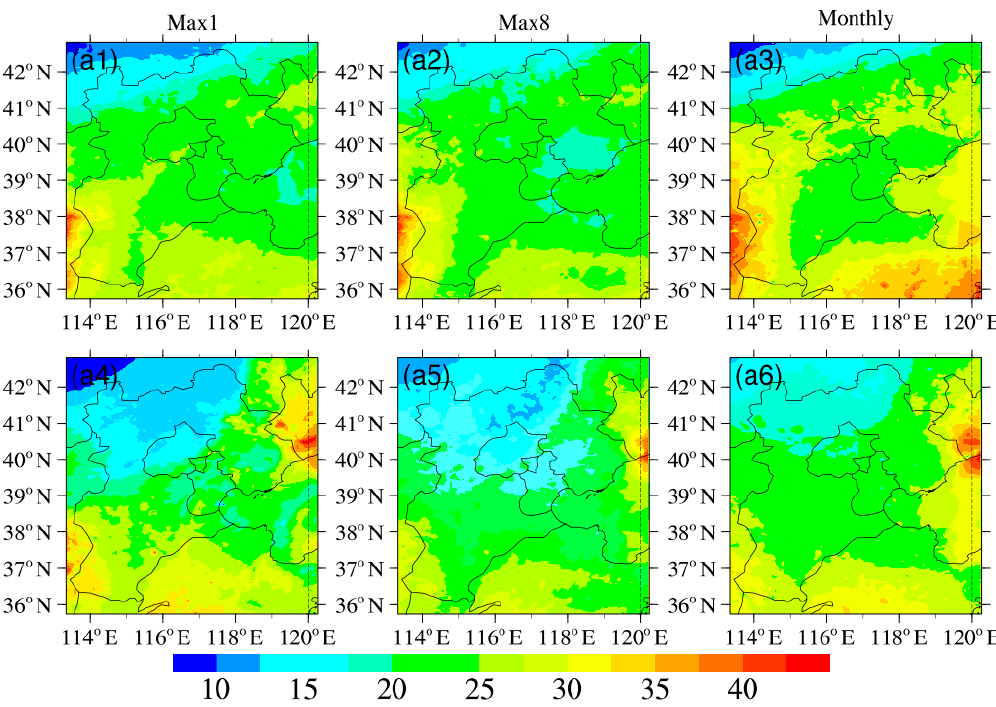
Figure 13. Monthly averaged contribution (µg/m 3 ) of BVOCs to ozone formation in July and August 2017 over the NCP ( a1 – a6 ); the left column represents the maximum 1-h average, the middle column represents the maximum 8-h average, the right column represents the monthly average, and the rows from top to bottom represent July and August.